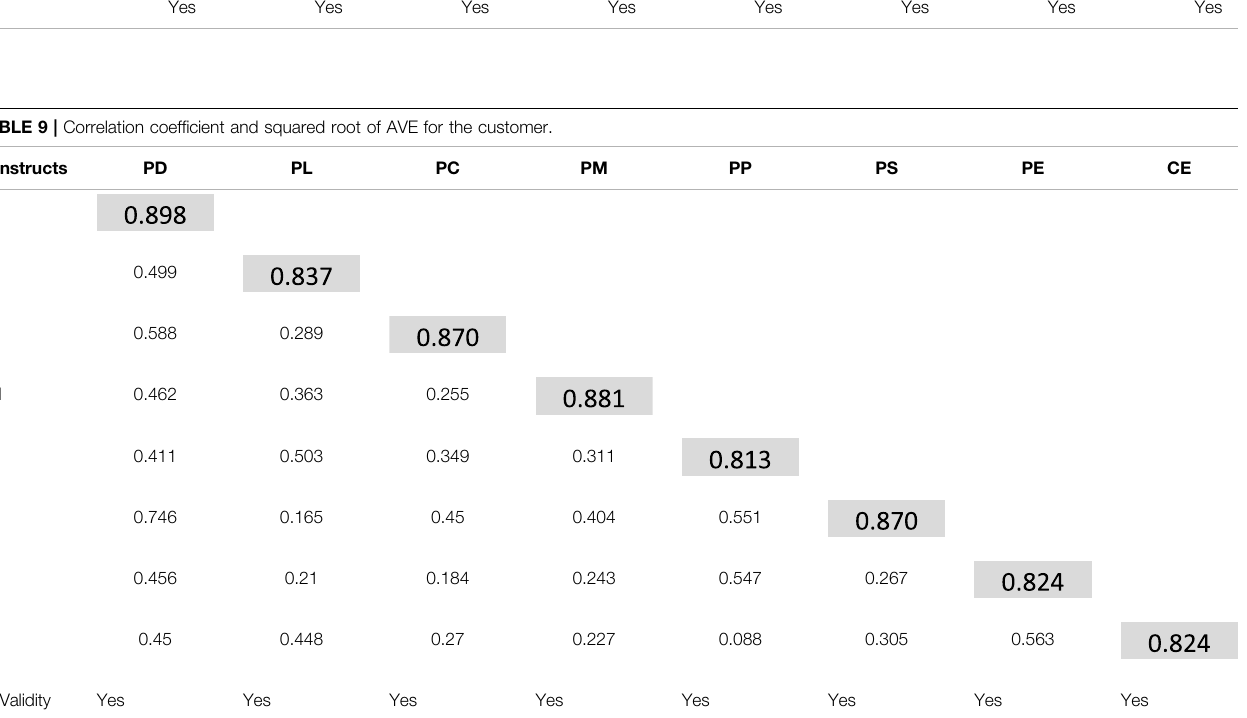
a Shaded diagonal is the squared root of AVE, and all other values are correlation coef fi cients.